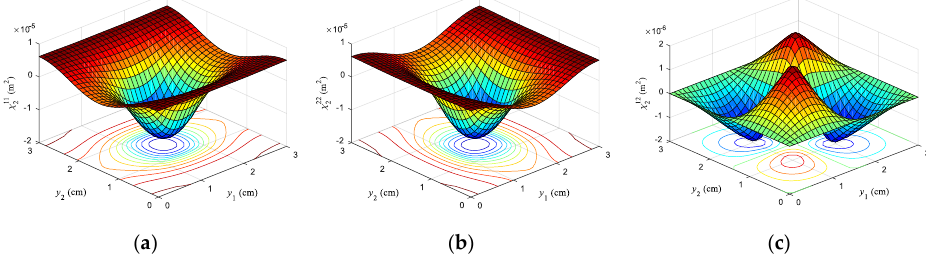
Figure 9. Second-order influence function 𝝌 2 of the CCCC single-layer periodic plate. ( a ) 𝑚𝑛 = 11 ; ( b ) 𝑚𝑛 = 22 ; ( c ) 𝑚𝑛 = 12.